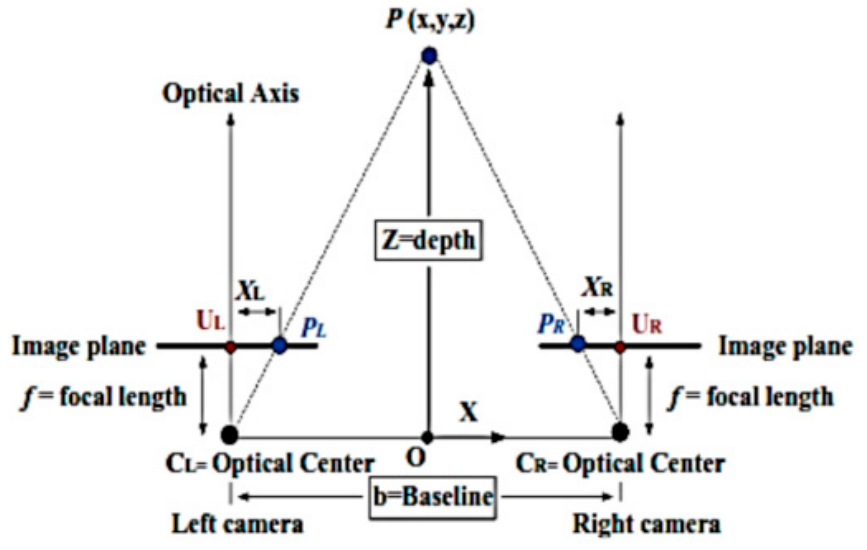
Figure 3. Functional blocks of the proposed visual recognition system.